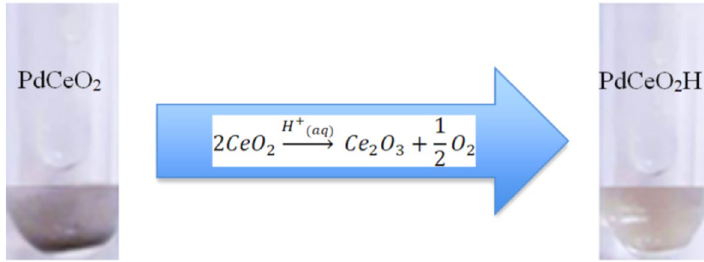
Figure 5. Modification of the color the PdCeO 2 nanofluid after hydrogenation.